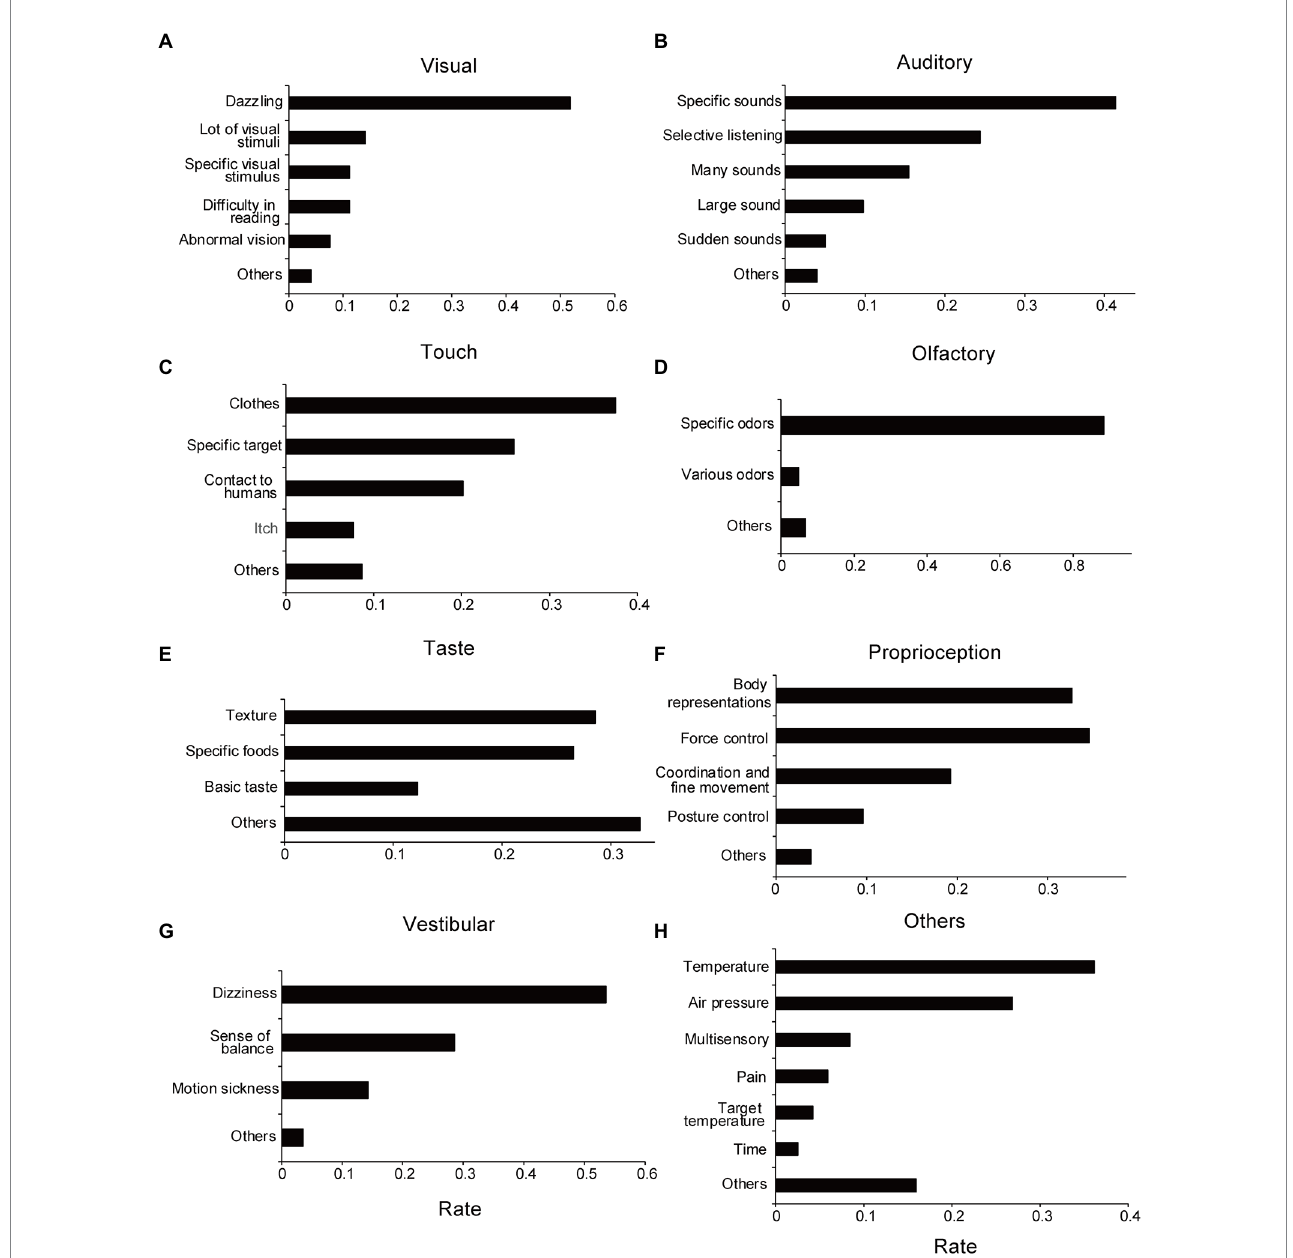
FIGURE 3 Categories of sensory issues extracted from free-writing fields. (A) Visual. (B) Auditory. (C) Tactile. (D) Olfactory. (E) Taste. (F) Proprioception. (G) Vestibular. (H) Others sensory issues. The rate of each category represents the ratio of response numbers to the total number of sensory issues aggregated by each modality. Note that when multiple categories are included in a single submission, they are counted in